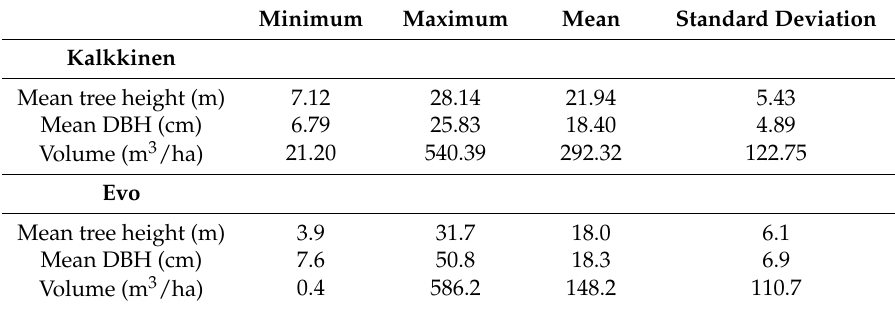
Table 1. Descriptive statistics of Kalkkinen (33 plots, 963 trees) and Evo forest data (292 plots, 8763 trees). Height, diameter at breast height (DBH), and volume are given.